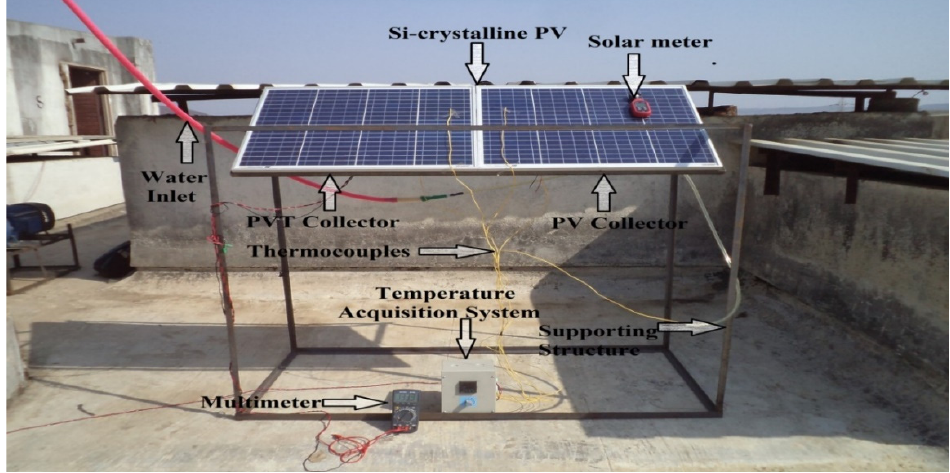
Figure 1. Experimental setup.